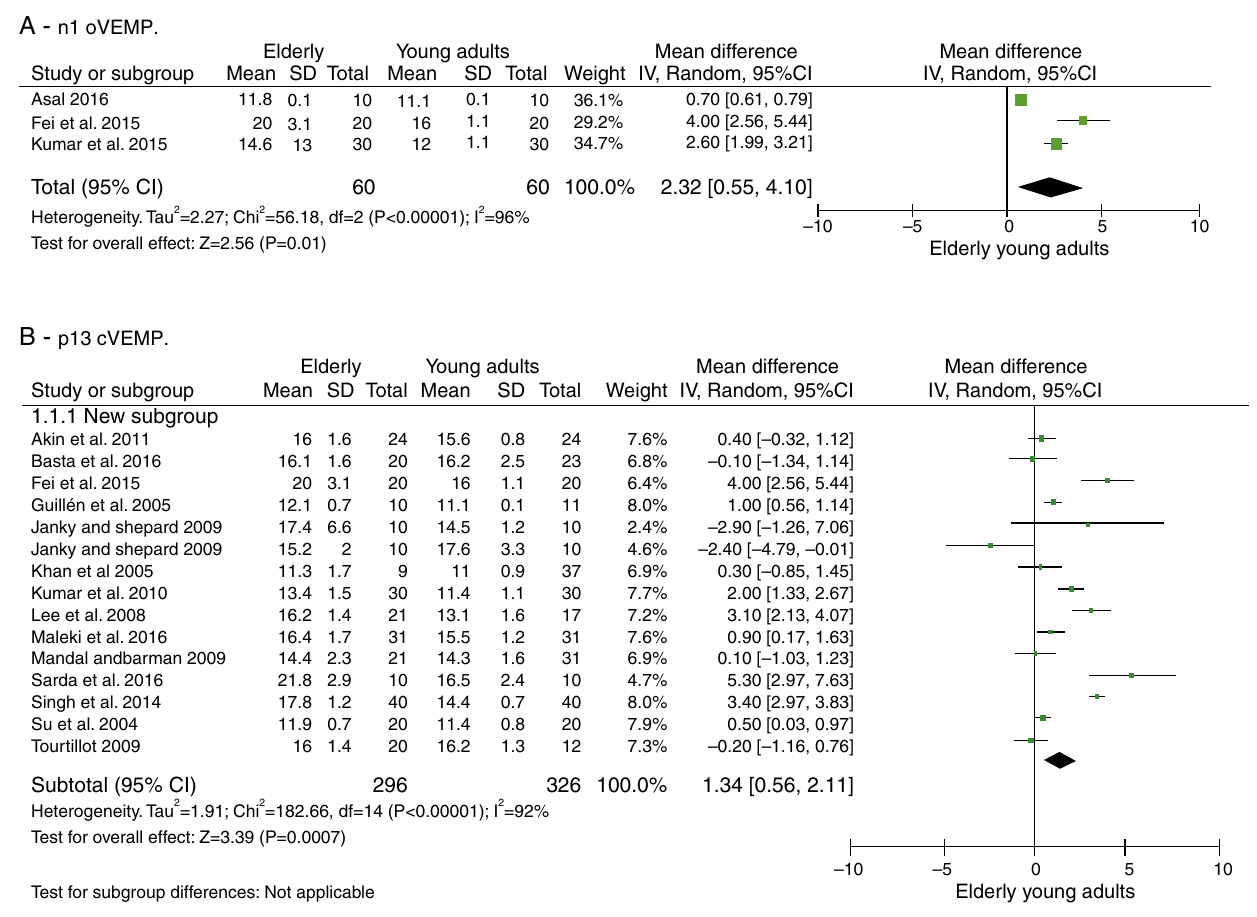
Meta-analysis: comparison of n1 oVEMP and p13 cVEMP latencies. (A) n1 oVEMP. (B) p13